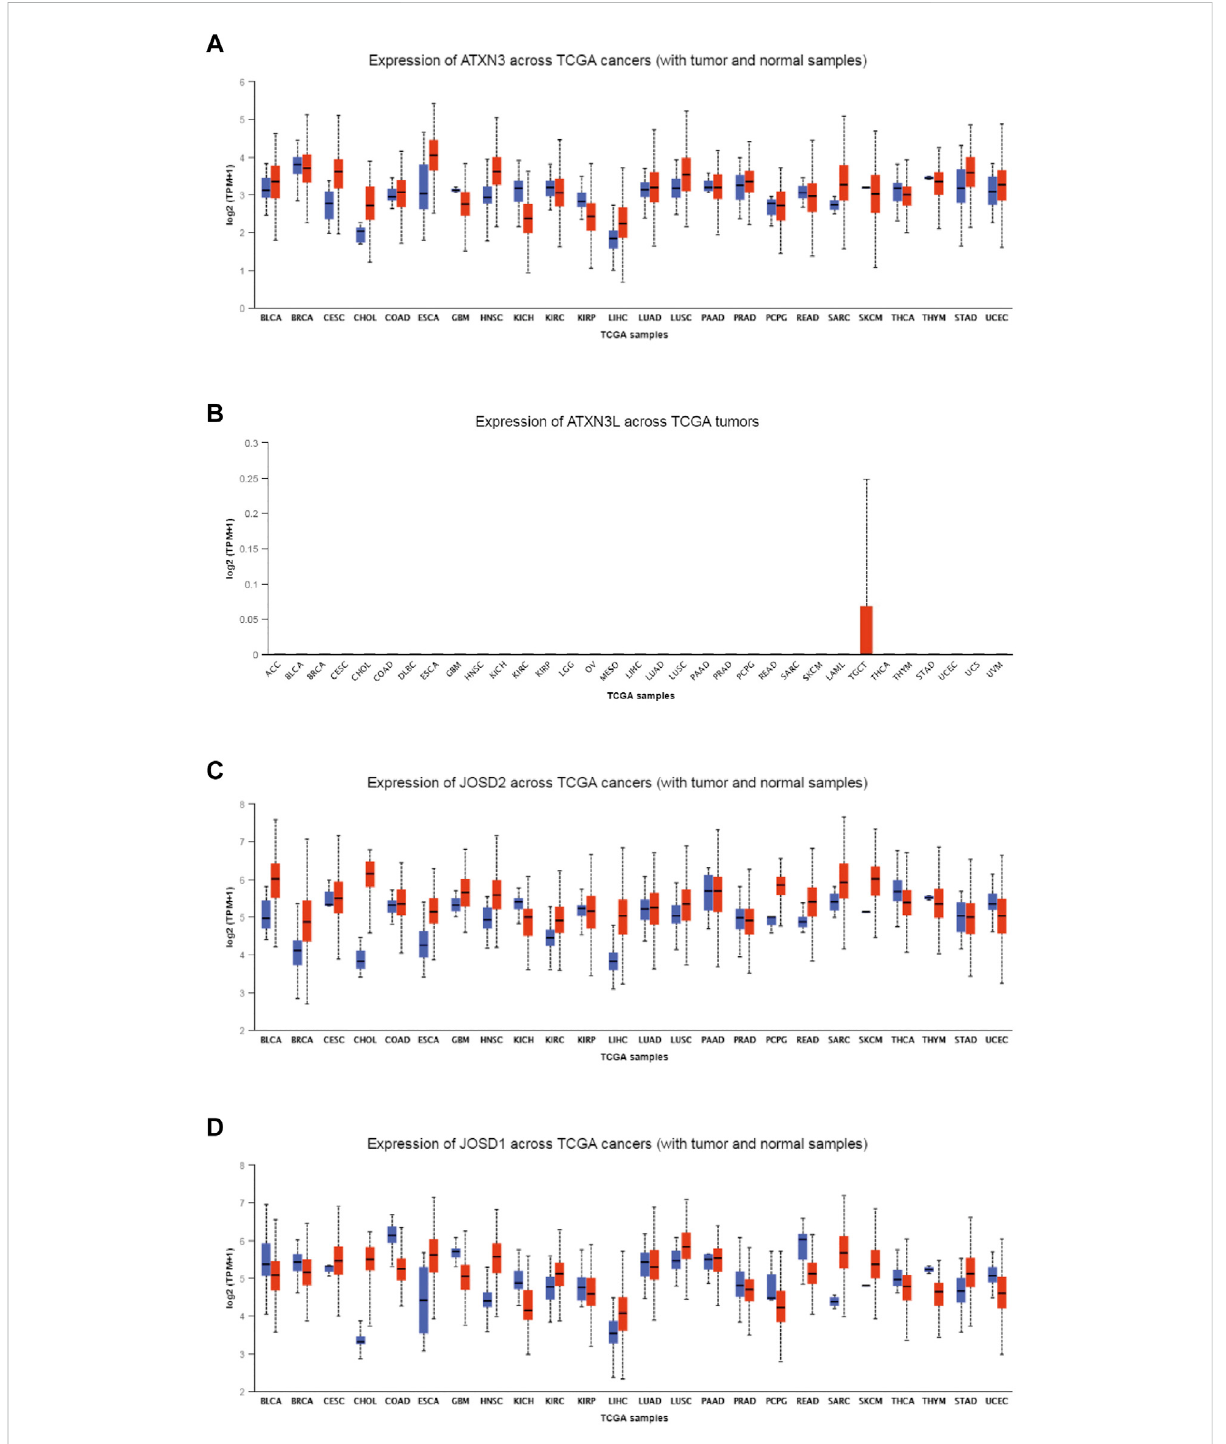
FIGURE 1 (A – D) The expression levels ofMJDs familymembersindifferenttypes ofcancers. ThemRNA expression levels ofATXN3,ATXN3L, JOSD1,and JOSD2 were compared with various TCGA